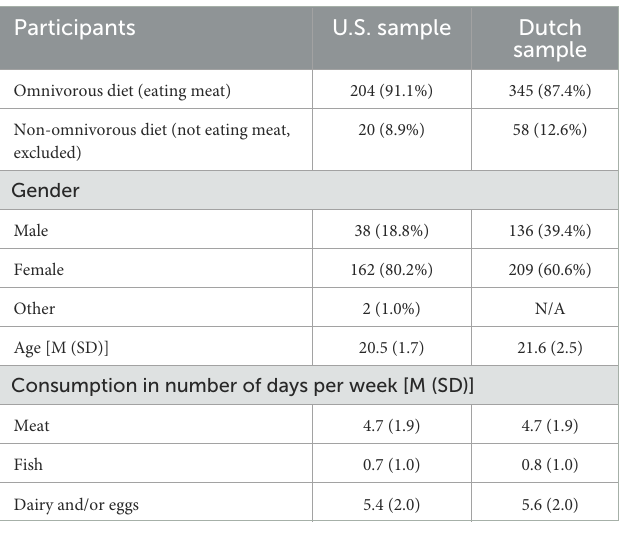
TABLE 3 Descriptives for gender, age and meat, fish, dairy, and/or egg